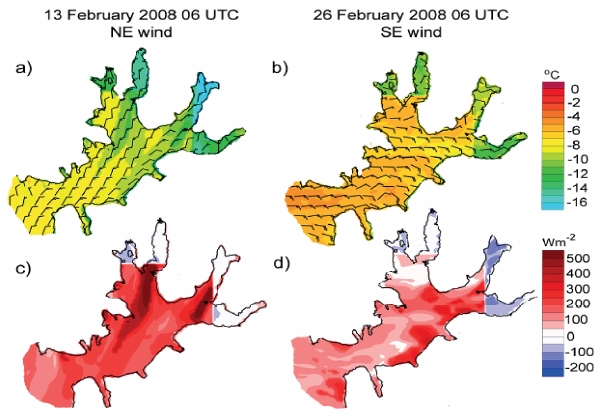
Figure 5. Examples demonstrating large spatial variations in air temperature and wind ( a and b ) and sensible heat flux ( c and d ) over a complex fjord (Isfjorden in Svalbard, length approx- imately 100km), as simulated applying a high-resolution atmo- spheric model. Redrawn with permission from Kilpeläinen